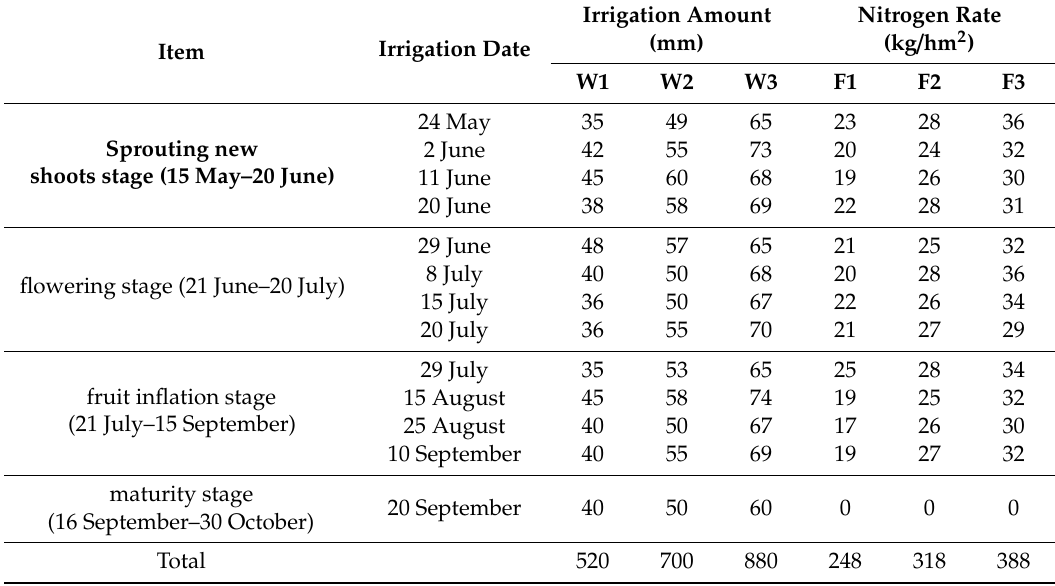
Table 2. Irrigation amount on the di ff erent irrigation treatments applied to jujube trees in